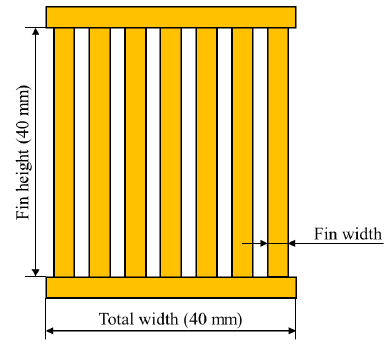
Figure 3. Sketch of the heat sink.